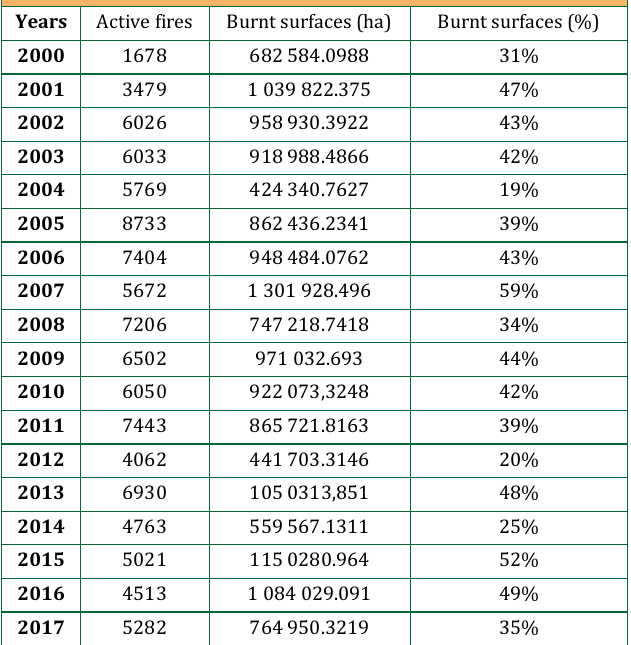
Table 1: Summary of results for the fires from 2000 to 2017